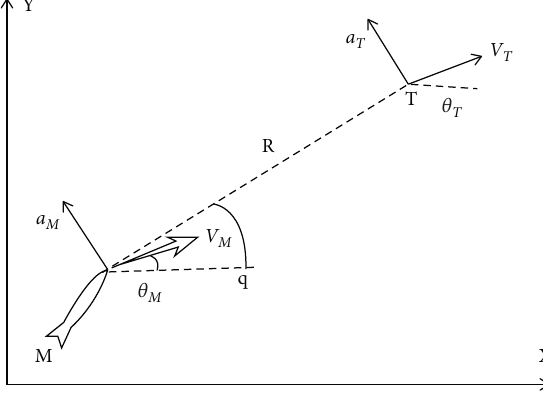
Figure 1: The relative motion of the missile and